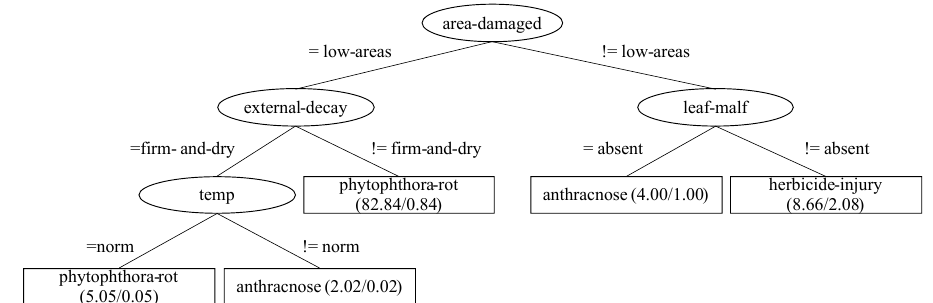
Figure 6. Excerpt of a decision tree for soybean seed disease